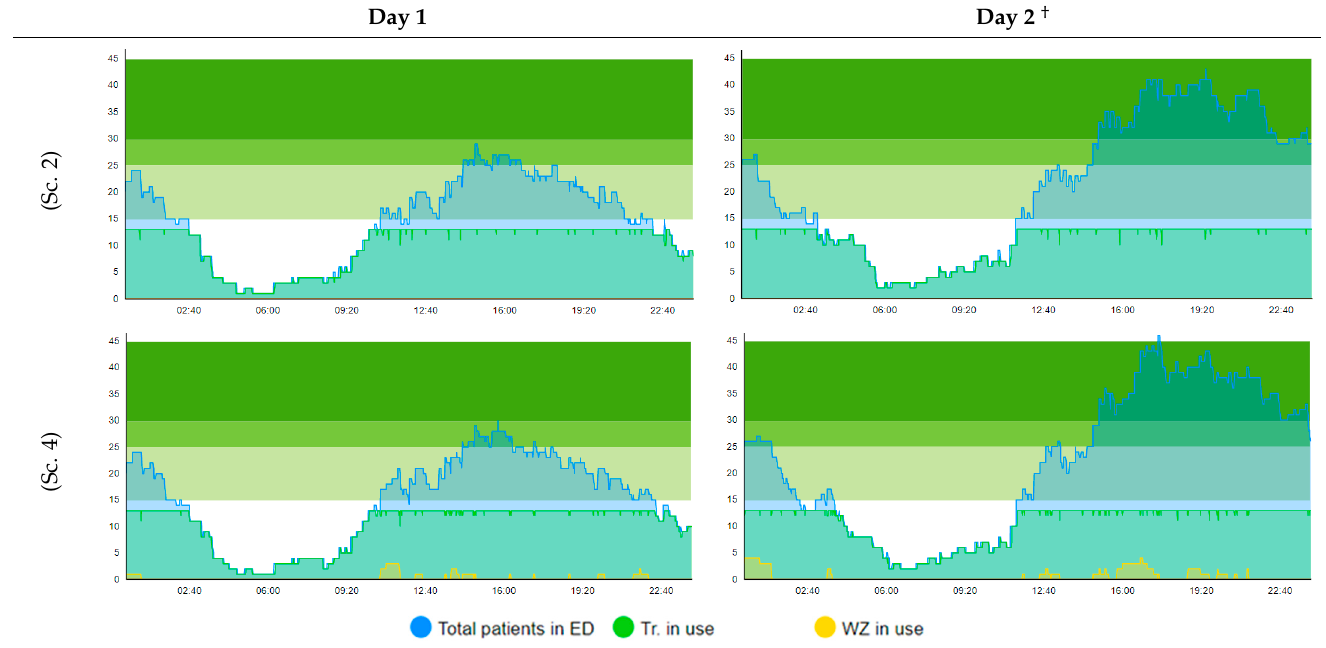
Table 13. Table displaying a subset selection of KPI from Sc.5. Key Patient